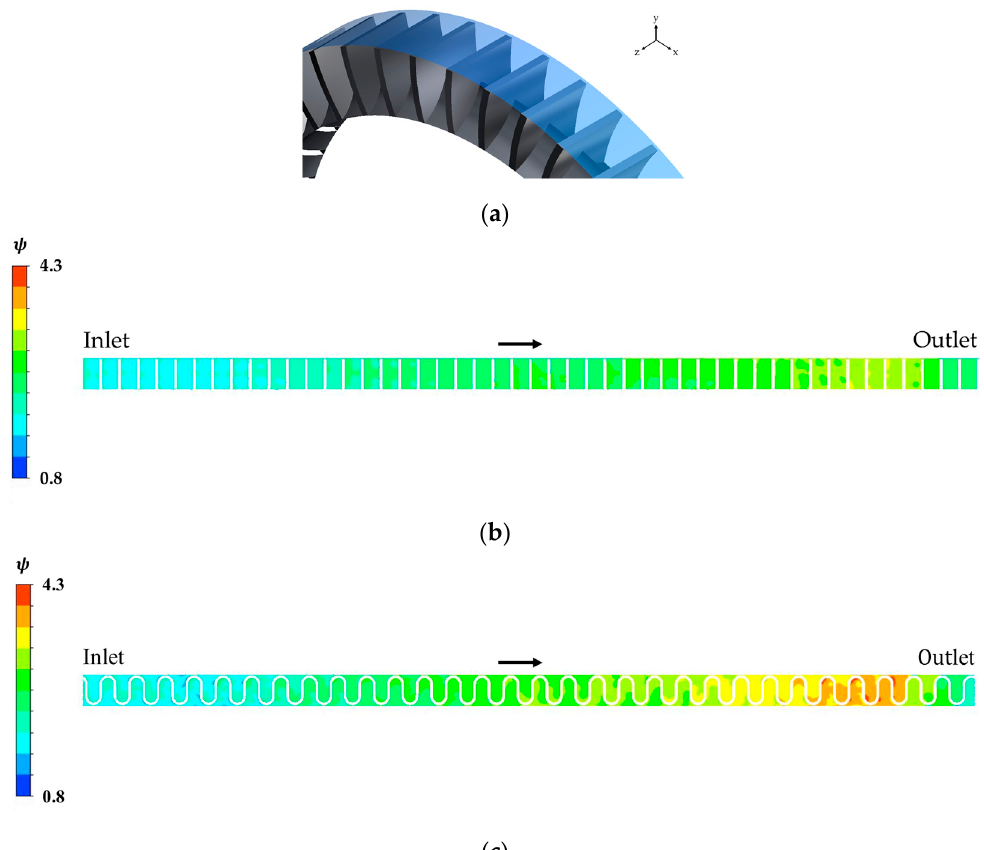
Figure 20. Pressure contours at the outer plane of the impeller: ( a ) measuring position; ( b ) reference pump; ( c ) optimized